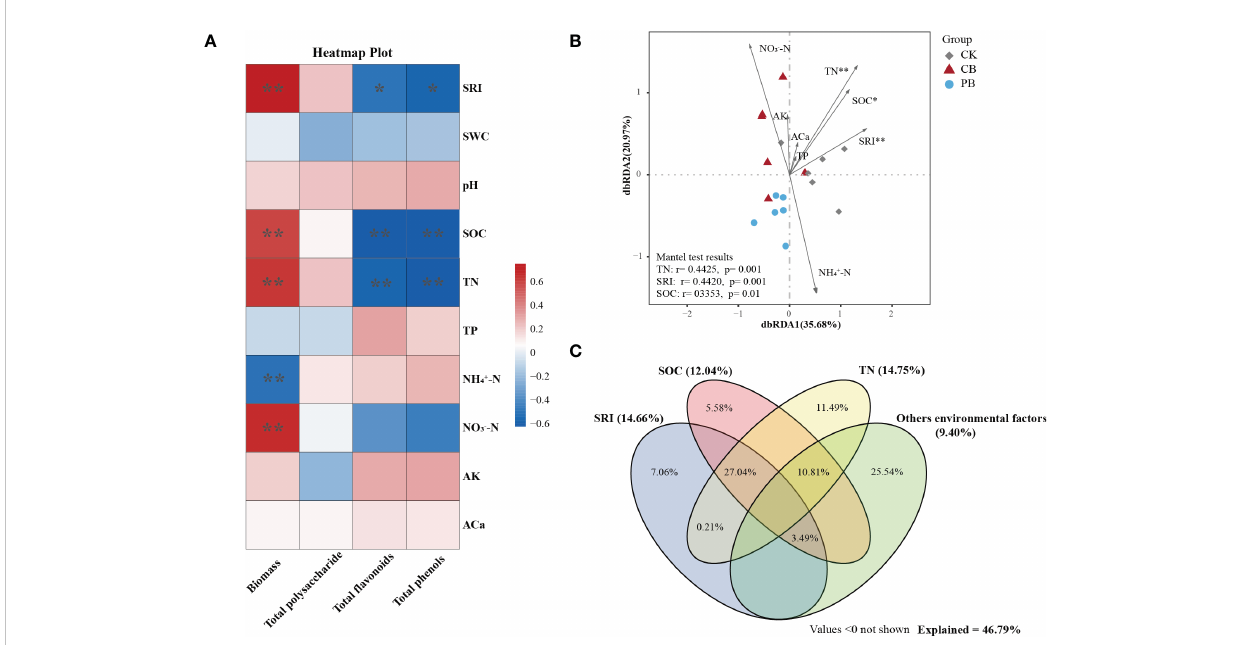
FIGURE 6 Effects of environmental factors on economic and functional traits. (A) The correlation (Spearman) between environmental factors and economic character of Bletilla pseudobulb. (B) The metabolic pro fi les of Bletilla pseudobulb were demonstrated by distance-based redundancy analysis (db- RDA), using environmental factors as explanatory variables; CB: C. paliurus intercropping with B. striata, PB: Moso bamboo intercropping with B.striata, CK: control group. (C) Variance partitioning analysis (VPA) of the effects of environmental factors on metabolic pro fi les of Bletilla pseudobulb. * p <0.05 and ** p